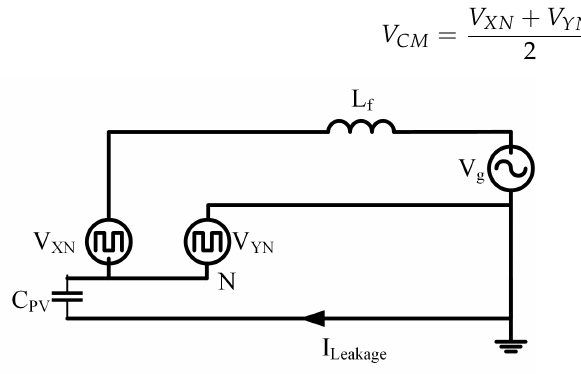
Figure 13. BBSM equivalent circuit to show path for leakage current.